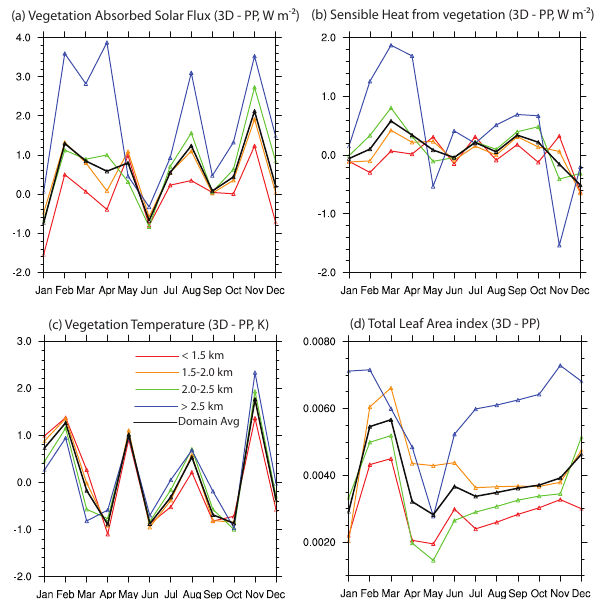
Figure 6. Deviations (3-D–PP) in the domain-averaged monthly (a) vegetation absorbed solar flux, (b) sensible heat flux from vege- tation, (c) vegetation temperature, and (d) total leaf area index for a 12-month period as a function of elevation lower than 1.5km (red), 1.5–2km (orange), 2–2.5km (green), above 2.5km (blue), and for the whole domain